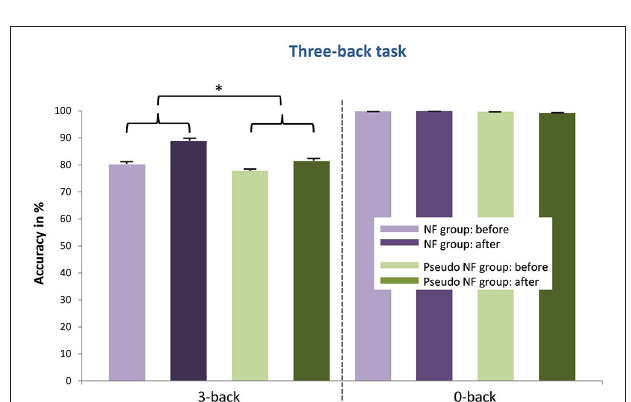
FIGURE 3 | Provides the mean accuracy scores (and standard error of mean) in the three-back task of the NF group (left) and the pseudo-NF group (right) for each condition (three-back vs. zero-back) before and after the training intervention . Significant differences (marked with a star) between accuracy enhancements (pre- post differences as depicted with curly brackets) were detected in the three-back condition between both groups showing stronger improvements after proper NF